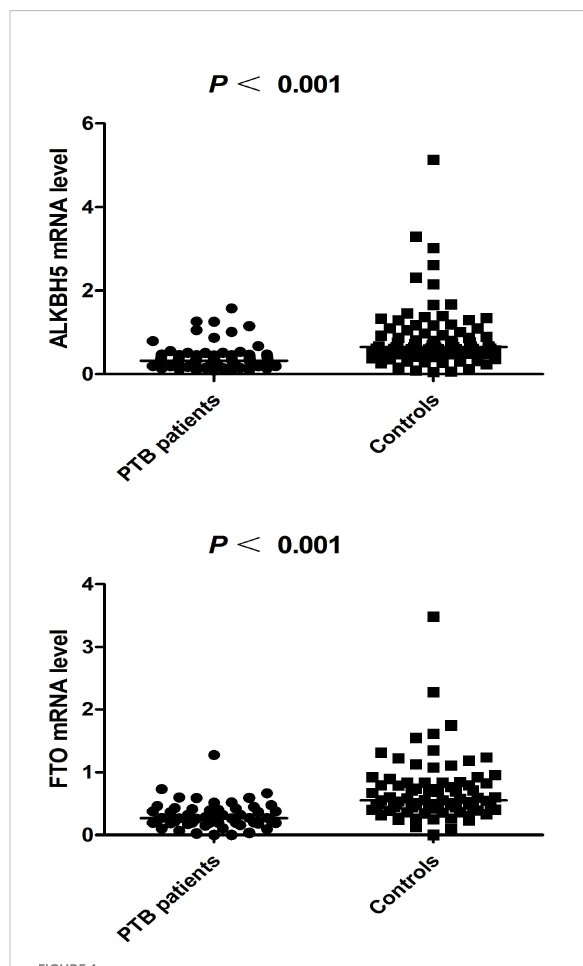
FIGURE 1 The expression levels of ALKBH5, FTO in PTB patients and controls (The subjects were selected from 449 patients and 463 controls).